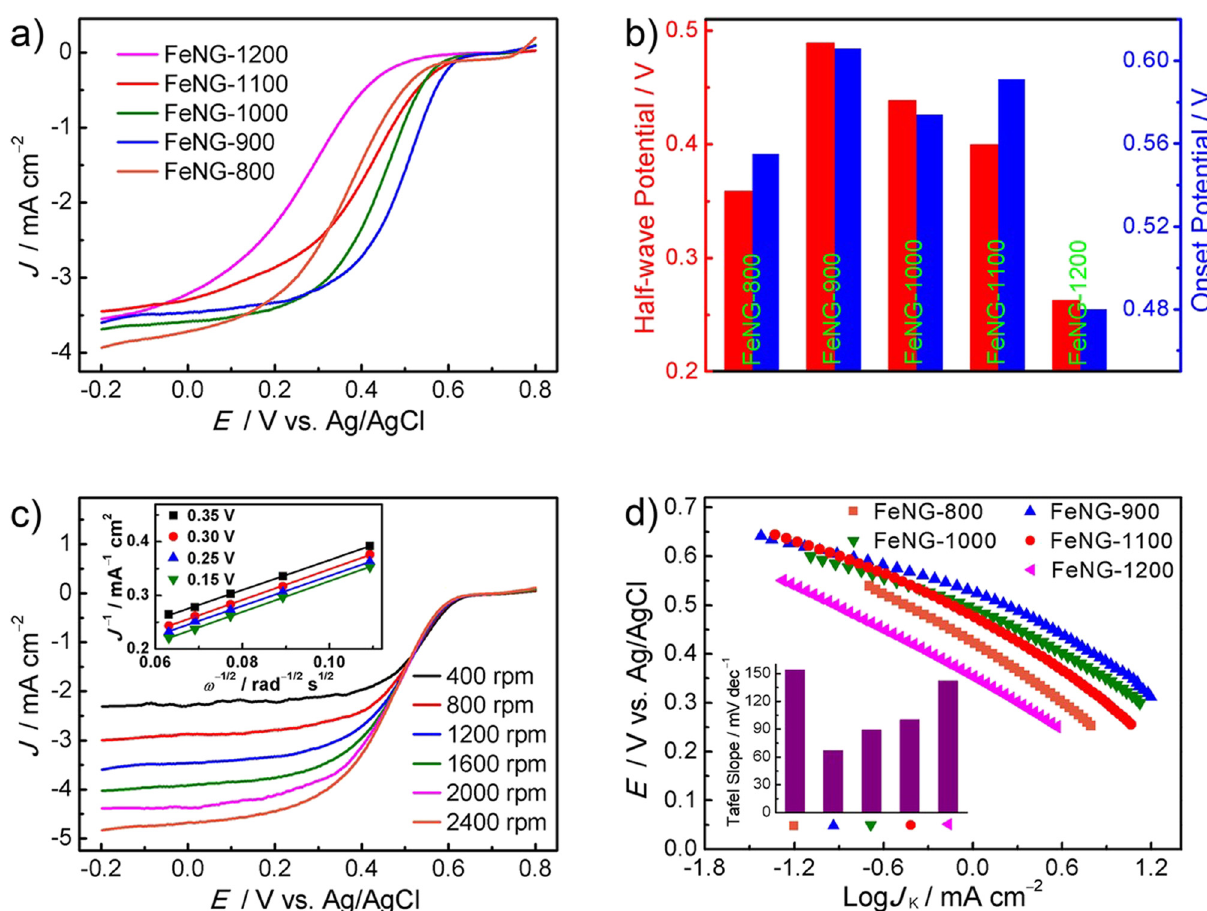
Figure 42: ORR electrochemical activities of FeNG catalysts in 0.1 M KOH electrolyte: ( a ) various linear sweep voltammetry ( LSV ) curves of samples at a 5 mV s − 1 scan rate and 1,200 rpm rotation rate; ( b ) E 1/2 and E O values obtained from LSV curves in ( a ) ; ( c ) FeNG - 1,100 LSV curves at a 5 mV s − 1 scan rate and various rotation speeds, and ( d ) LSV data - based Tafel plots for FeNG catalysts. Copied with permission from ref. [ 451 ] ; John Wiley and Sons,